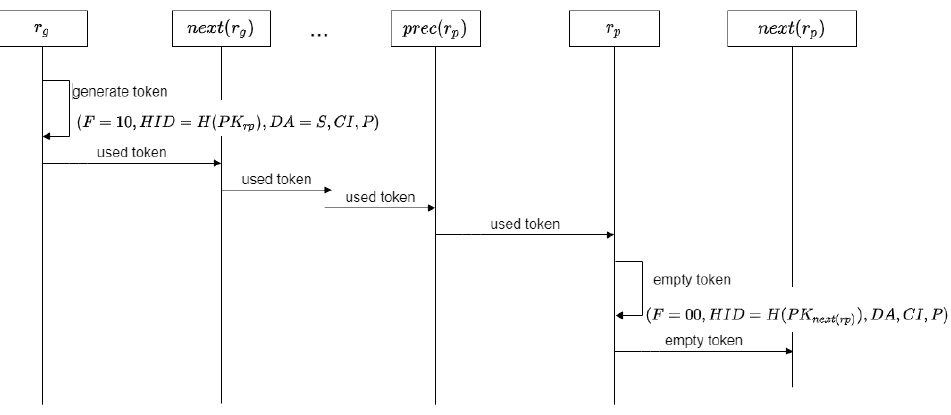
Figure 3. Process of generation of the